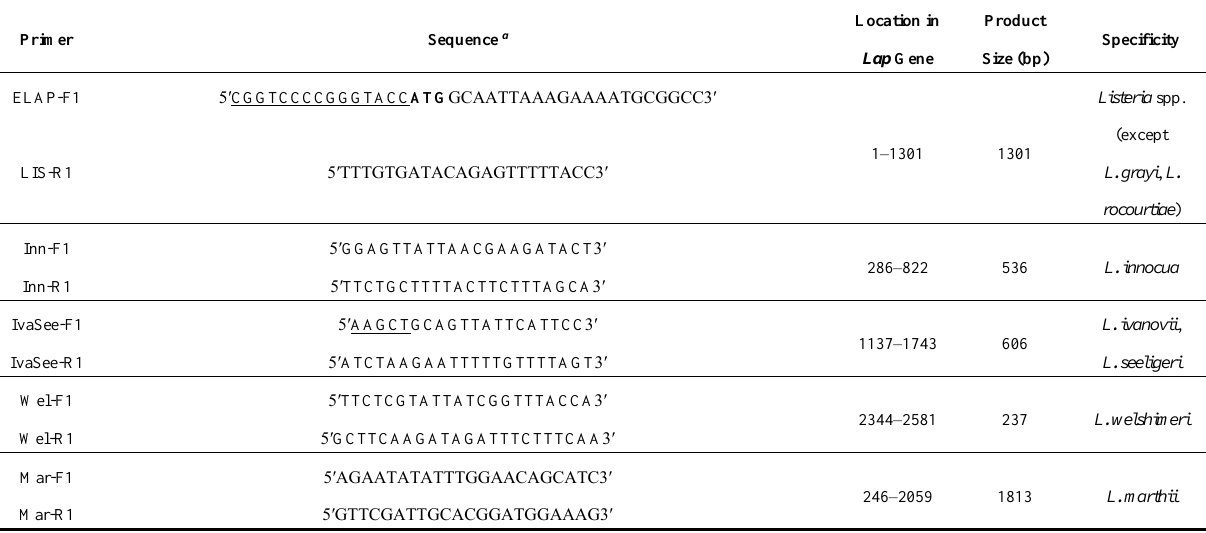
Figure 1. Schematic representation of the lap ( aad ) gene-specific primer binding sites for PCR-based detection of Listeria . Open block arrow represents genes flanking the lap . Abbreviations represents (similar proteins to): trpE , anthranilate synthase alpha subunit; lmo1634 , alcohol-acetaldehyde dehydrogenase (LAP); lmo1635 , unknown protein; lmo1636 , ABC transporter (ATP-binding protein); lmo1637 , membrane protein. The Listeria lap primers were specific for all species of Listeria sensu stricto tested, but not the atypical listeriae; L. grayi and L. rocourtiae . Colored boxes indicate primer binding sites for Listeria species (see Table 1 for PCR product size). Table 1. Sequences of species-specific primers based on lap sequence used in this